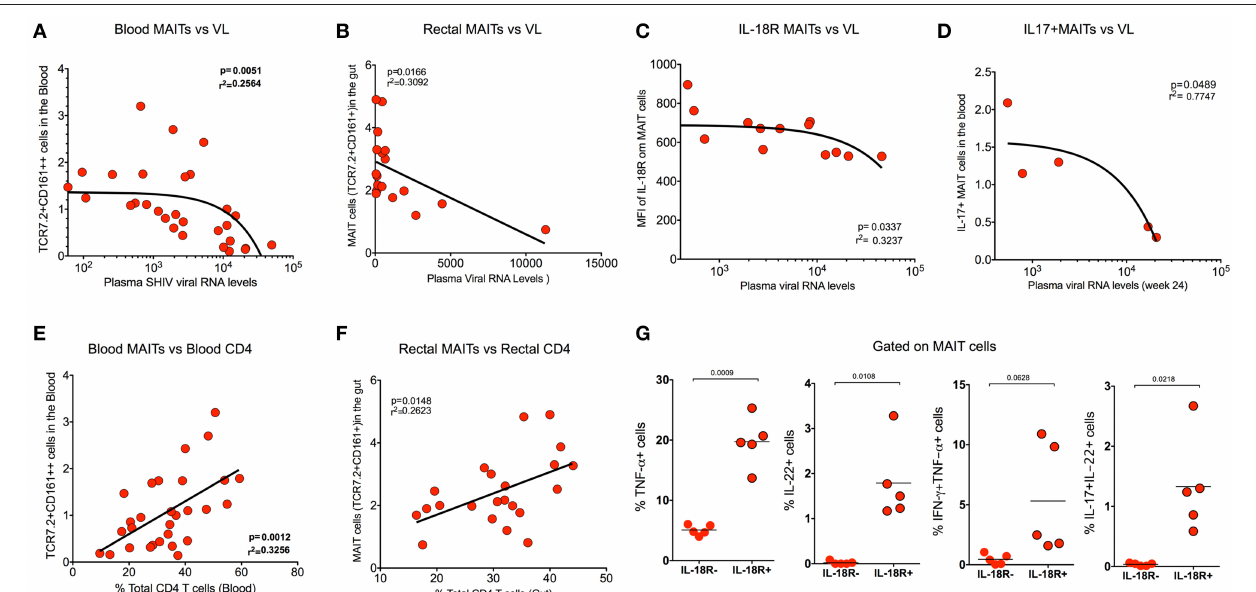
FIGURE 5 | MAIT cells correlate inversely with SHIV plasma viral RNA levels and directly with CD4T cell levels. (A) Plots showing the frequency of blood MAIT cells that correlated inversely with plasma SHIV viral RNA levels ( n = 29). (B) Plots showing the frequency of gut MAIT cells that correlates inversely with plasma viral RNA levels ( n = 18). (C) Plots showing the mean fluorescence intensity of IL-18R on blood MAIT cells that correlated inversely with plasma viral RNA levels ( n = 13). (D) Plots showing the frequency of IL-17 + MAIT cells that correlates inversely with the plasma viral RNA levels ( n = 5). (E) Plots showing the frequency of blood MAIT cells that correlates directly with the level of CD4T cells ( n = 29). (F) Plots showing the frequency of rectal MAIT cells that correlates directly with the level of CD4T cells in the rectum ( n = 24). (G) Plots showing the cytokines (TNF- α , IL-22, IFN- γ + TNF- α + , and IL-17 + IL-22 + cells) produced by IL-18R + and IL-18R- MAIT (IL-18R + CCR6 + CD161 ++ ) cells after PMA/ionomycin stimulation ( n = 5), suggesting that IL-18R expression is important for MAIT cell function during chronic SHIV